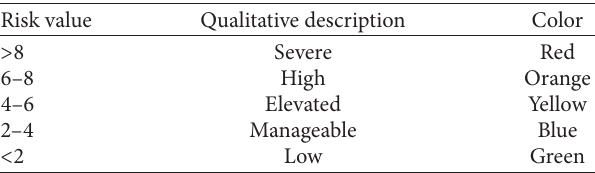
Table 2: Qualitative and numerical ratings for the risk value of a